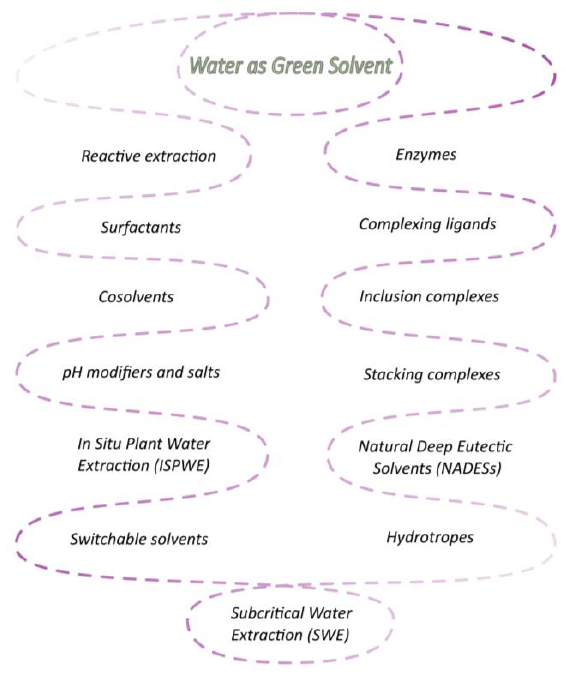
Figure 6. Water as green